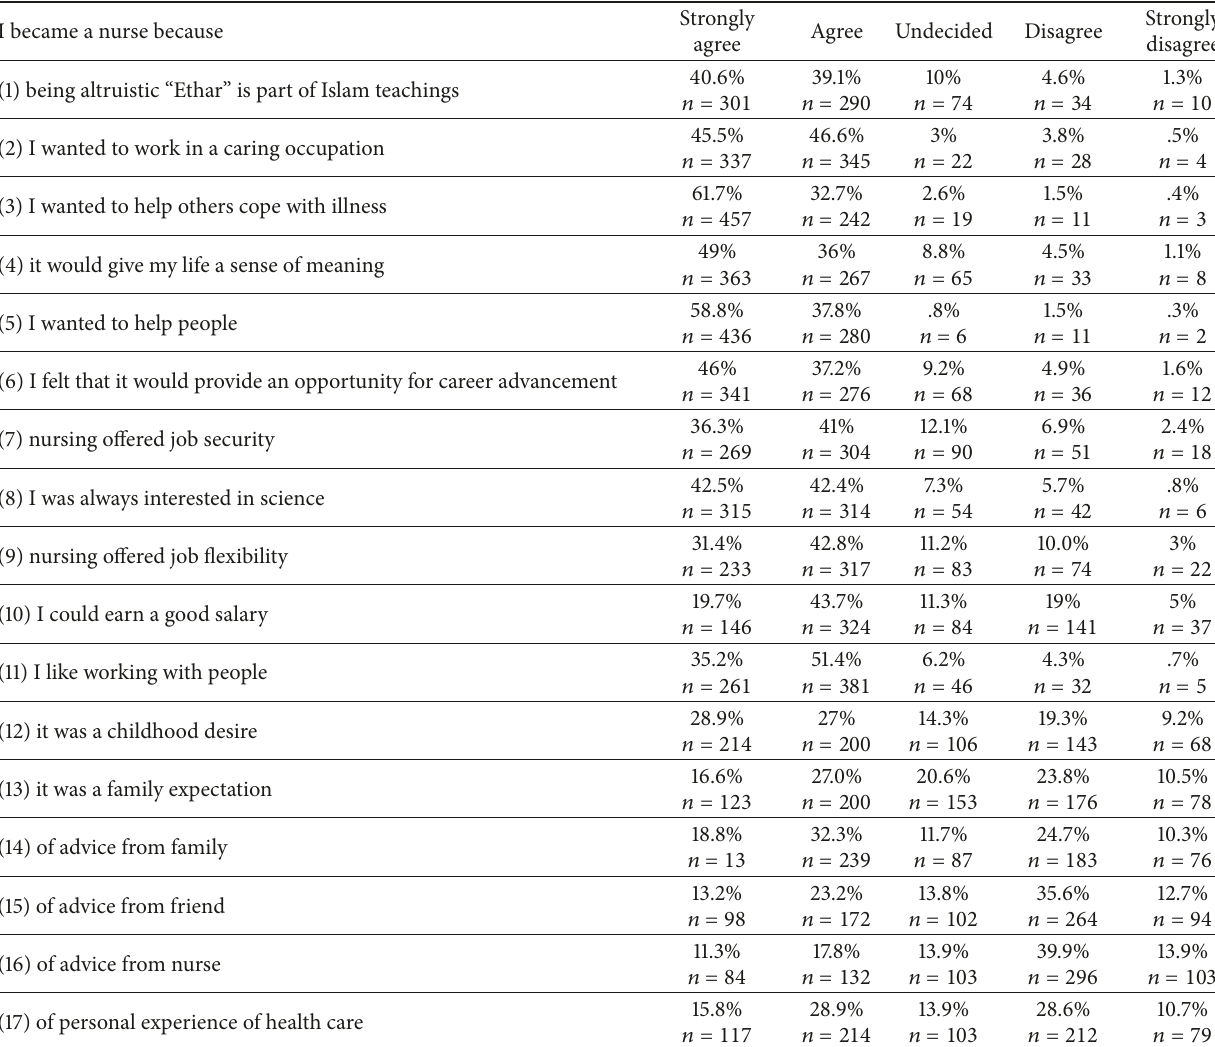
Table 3: Motivations to become a